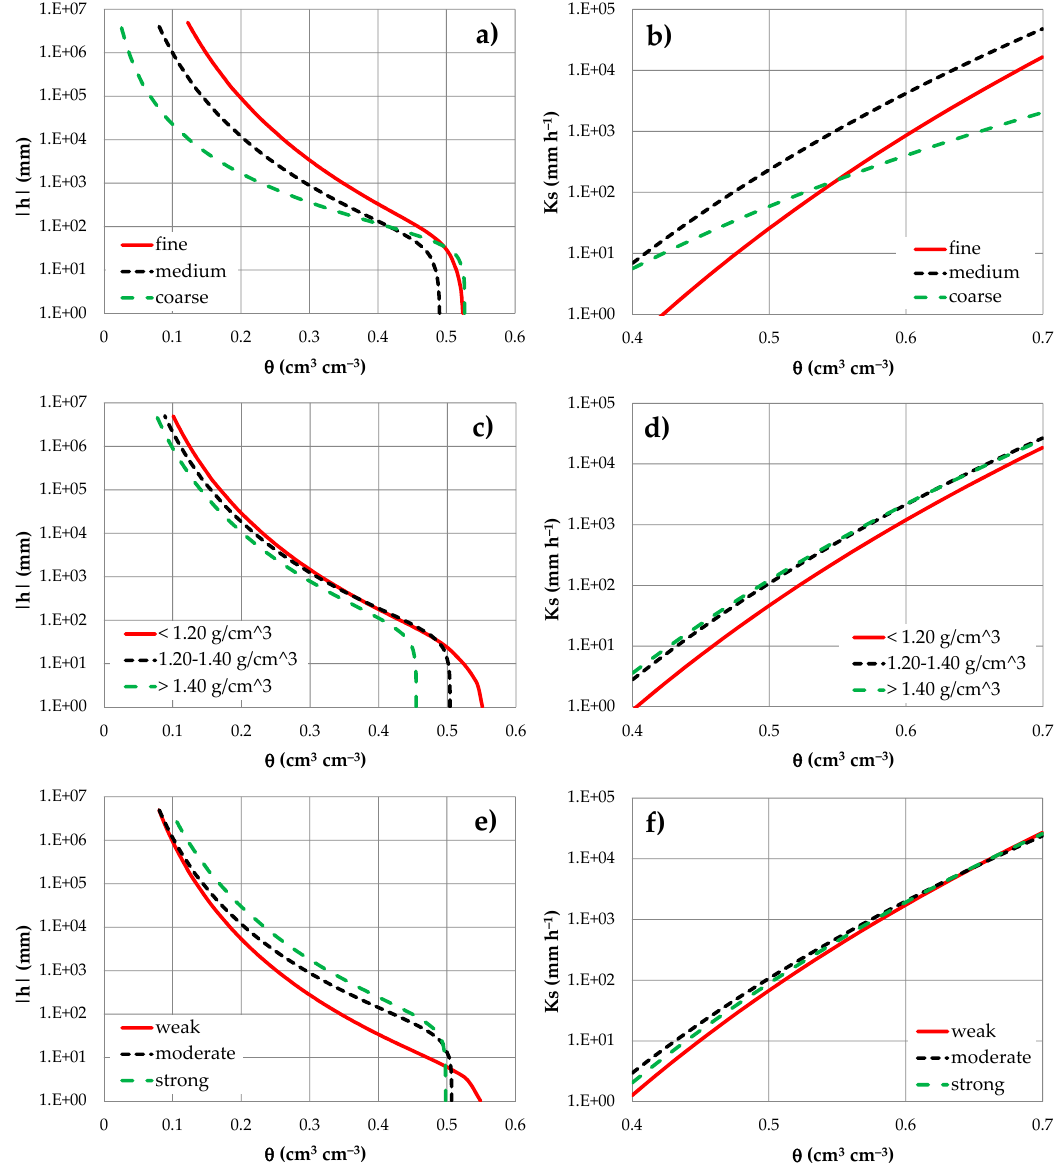
Figure 3. Soil water retention curve and hydraulic conductivity function (left and right, respectively) obtained for a given class of soil texture (fine, medium, and coarse; ( a , b )), soil bulk density range (lower than 1.2 g cm − 3 , between 1.2 and 1.4 g cm − 3 , and higher than 1.4 g cm − 3 ; ( c , d )), or soil capillarity class (10 < λ c < 42 mm, 42 ≤ λ c ≤ 250 mm, and 250 ≤ λ c ≤ 1000 mm representing weak, moderate, and strong, respectively; ( e , f )). Table 2. Mean and associated coe ffi cient of variation (in brackets) of air capacity (AC), plant available water capacity (PAWC), and relative field capacity (RFC) obtained for the three soil texture classes. Fine Medium